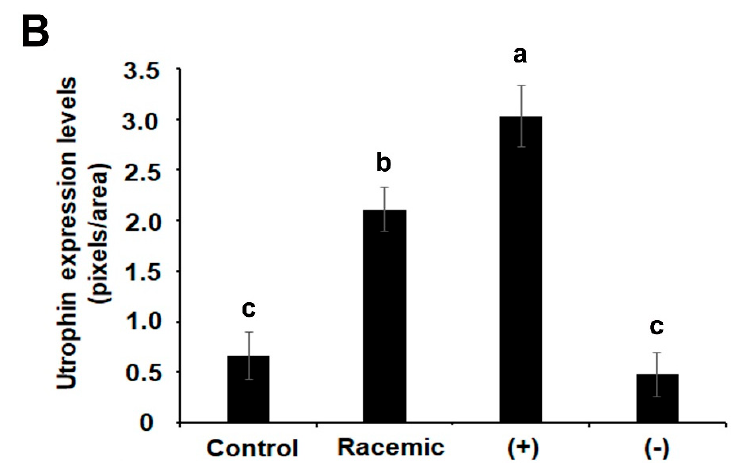
Figure 5. Utrophin levels in the experimental mdx mice at the age of 14 weeks. ( A ) Immunostaining of diaphragm sections derived from mdx mice with an antibody against utrophin (red staining, white arrows). Nuclei were stained with DAPI (blue). The sections were visualized by confocal microscopy. Bar, 50 µ m. ( B ) Quantification analysis of utrophin levels was performed on images of three mice with 10 sections/diaphragm ( n = 30). The results are presented as mean pixels/unit area ± SE. Bars with different letters indicate significant difference between treatments ( p <